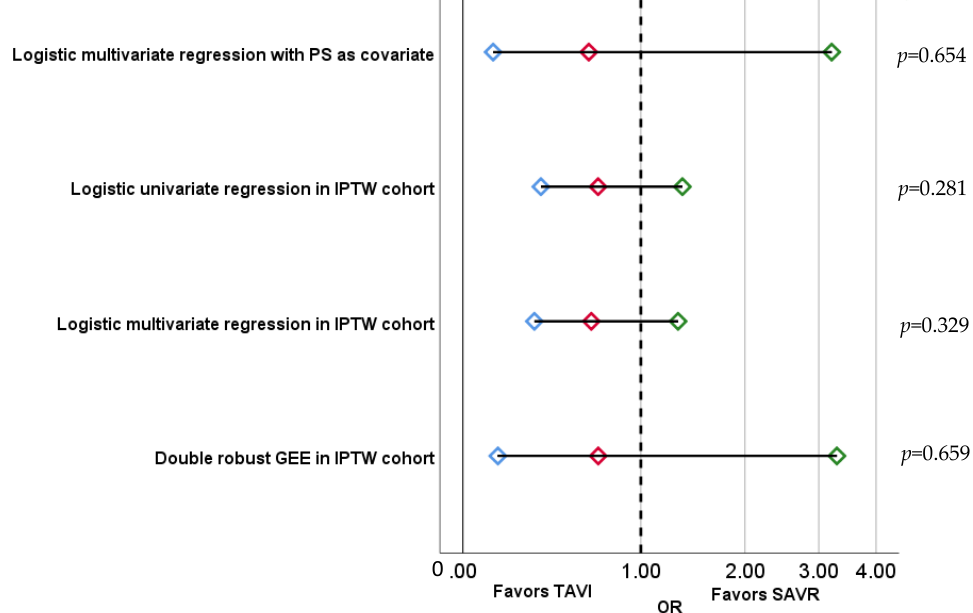
Figure 3. Association between aortic valve procedure and infective endocarditis after adjusting for cofounders with propensity score in different sensitivity analyses. Red dot indicates the Odds Ratio (OR), and the interval between blue and green dots indicates 95% confidence interval for the OR. TAVI: Transcatheter aortic valve implantation. SAVR: Surgical aortic valve replacement.